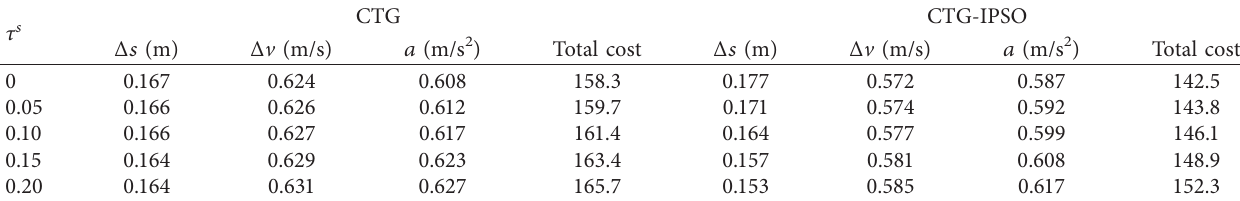
Table 3: Sensitivity analysis of communication lag of CTG and CTG-IPSO.